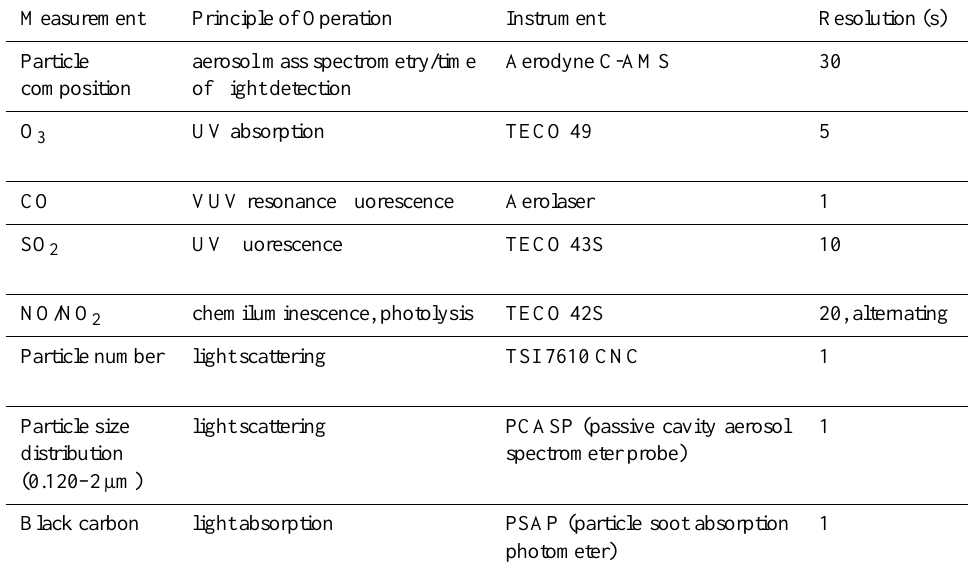
Table 2. Summary of trace gas and particle instrumentation on the Twin Otter